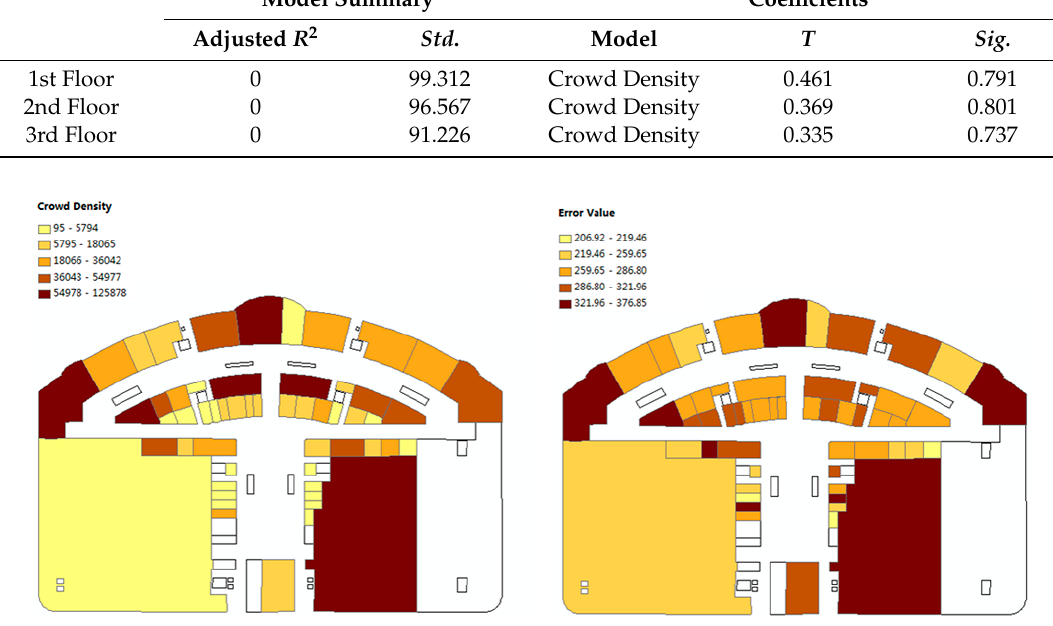
Figure 13. Statistical results of the crowd density and the error in the stores.